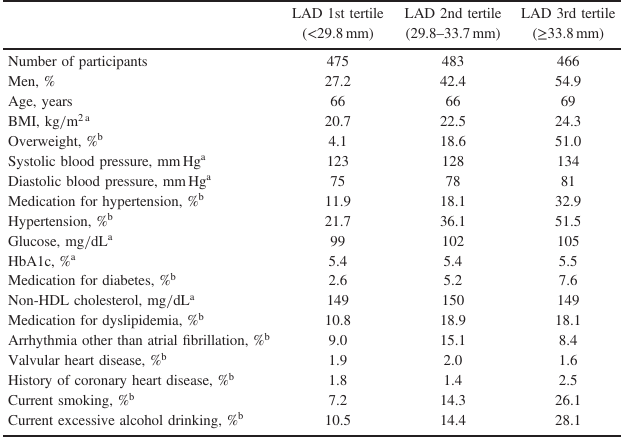
Table 3. Risk of LAD increase for the incidence of AF in 1,424 participants: the Suita study Left atrial dimension Tertile of left atrial dimension T1 (<29.8mm)